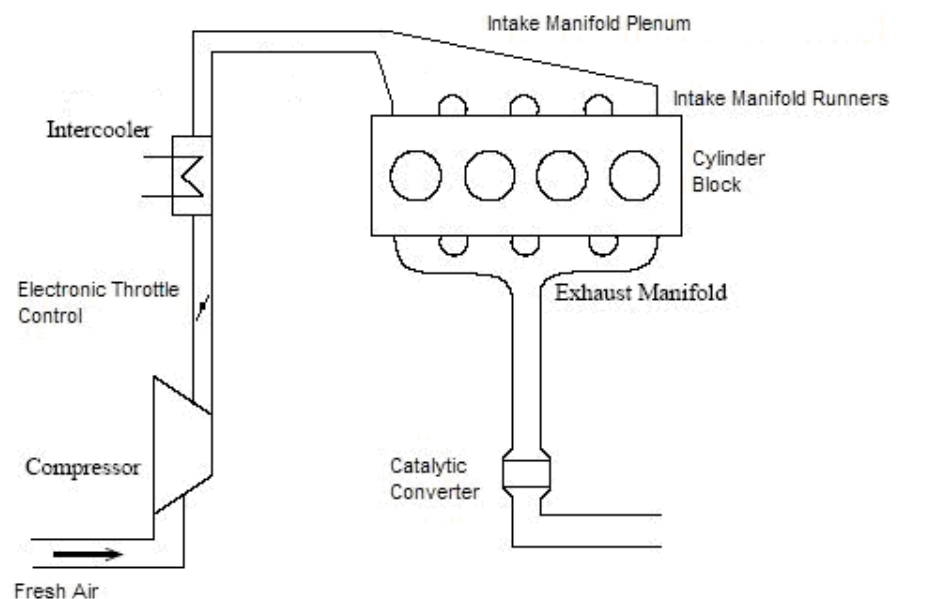
Figure 2. Intake manifold of a four-cylinder supercharged diesel engine [19,23].